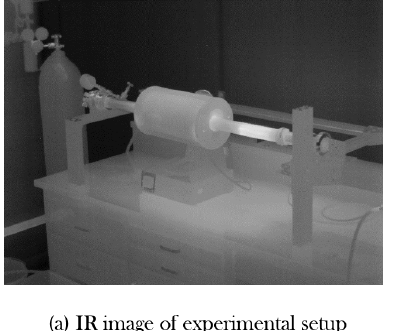
Figure 1. Experimental test setup.